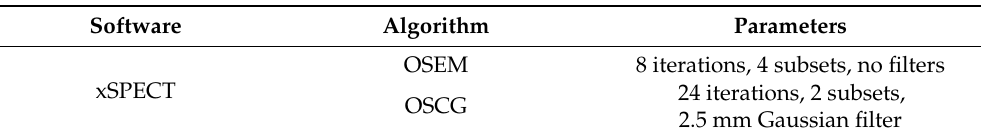
Table 2. Raw SPECT data for the reference cylindrical phantom were reconstructed using both the Symbia Intevo SPECT/CT built-in